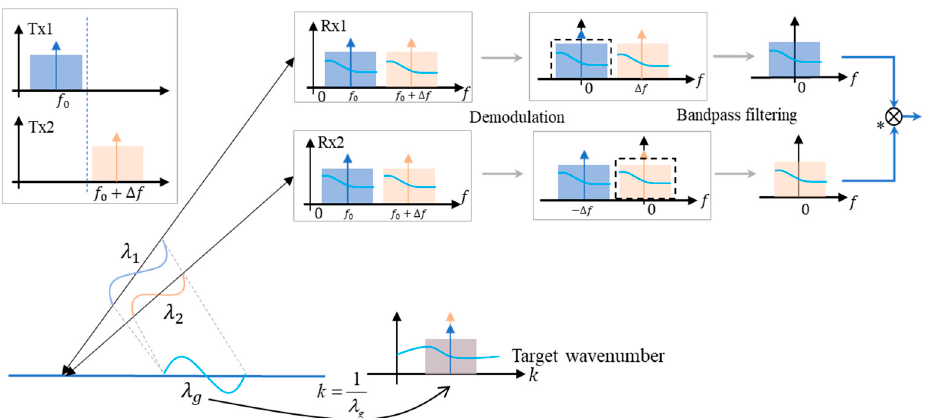
Figure 9. Proper design of carrier frequency shift (CFS) and signal bandwidth to avoid radio interference. The * along with the circle with a multiplication sign in it, stands for complex multiplication, which is a standard operation for SAR signal